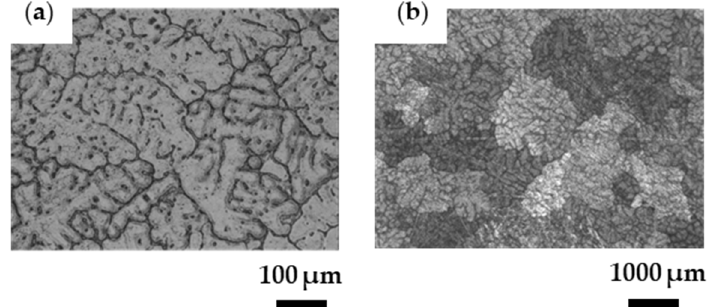
Figure 1. Grain structures of unrefined ( a ) Al-Cu and ( b ) Mg-Zn prior to in-situ neutron diffraction experiments.